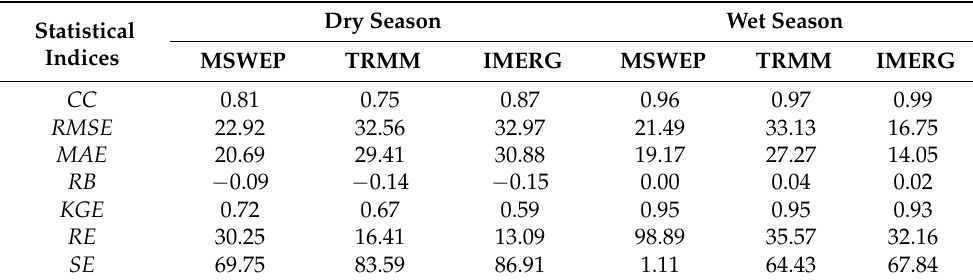
Table 4. Statistical indices between each gridded precipitation product and ground observation data at the watershed scale divided between the dry and wet seasons.